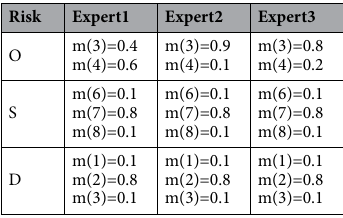
Table 9. belief structure of the first failure mode in application two.